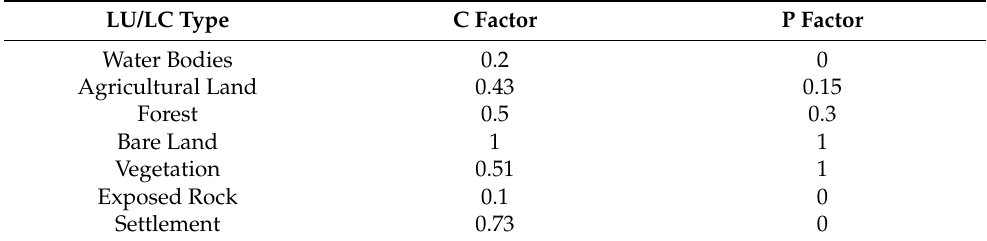
Table 4. C Factor and P Factor values used for different LU/LC types in MORB. Source: